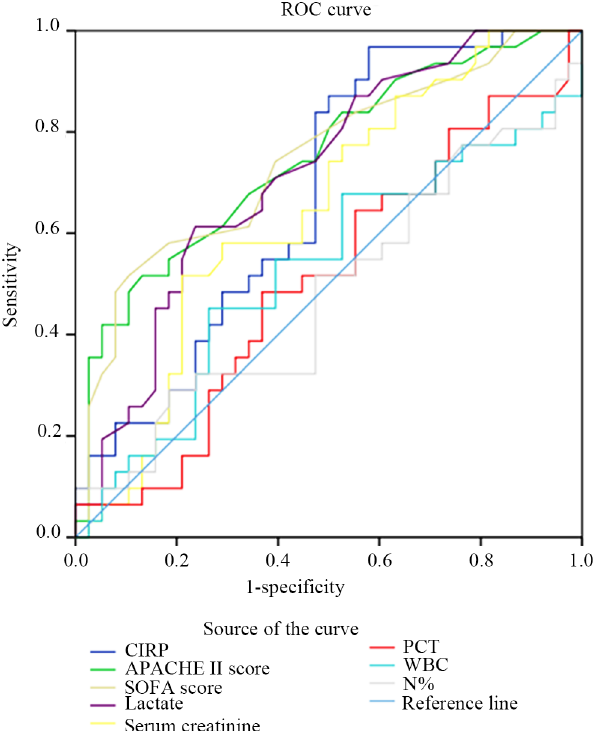
Fig 2. The ROC curves for the biomarkers and the severity scores. The areas under the ROC curve (AUCs) for the CIRP level, the APACHE II score, the SOFA score, the lactate level, the serum creatinine level, the PCT level, the WBC count, and the N% are